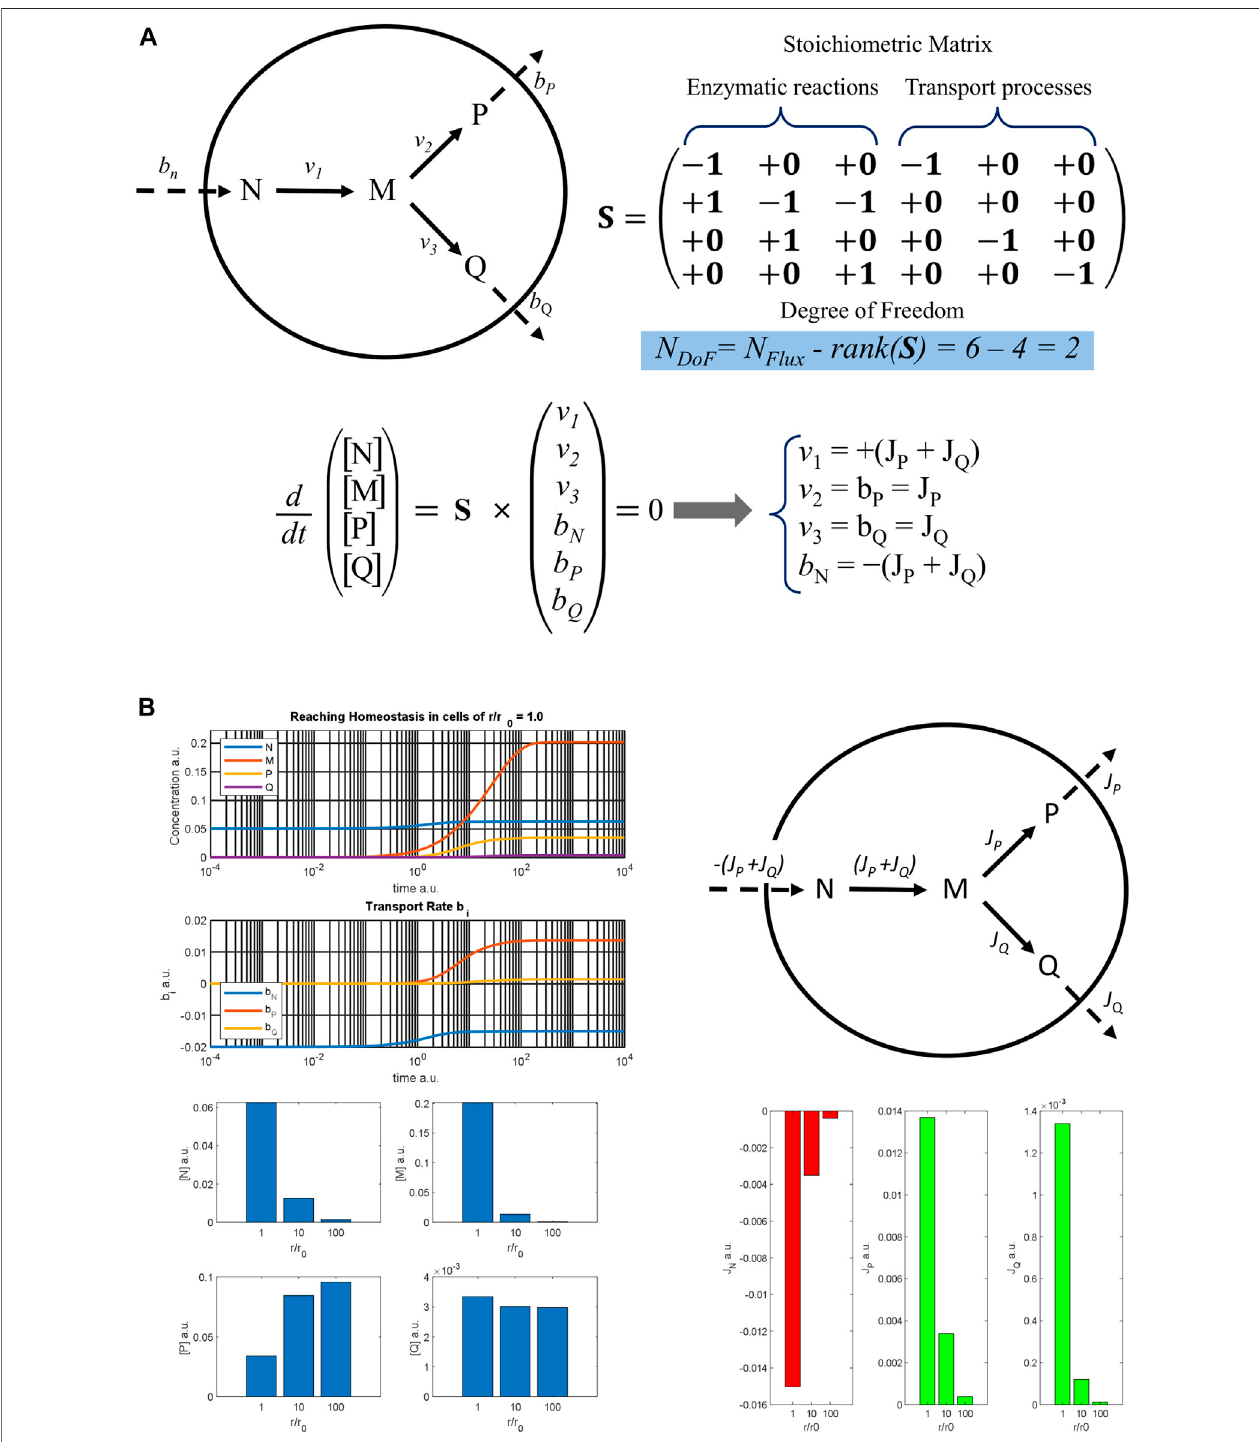
FIGURE 2 | Metabolic model of a three-enzyme pathway (A) A three-enzyme metabolic pathway model is reported with the result of the fl ux balance analysis. The rank of the stoichiometric matrix S is 4, so that the degree of freedom of the algebraic system obtained by applying the stationary condition for homeostasis is 2. Therefore, only two fl uxes, J P and J Q must be determined to know the stationary rates of all the processes at homeostasis. (B) On the top left, the time courses of the metaboliteconcentrationsandoftheratesofthetransportprocessesarereportedagainsttime,showingacellwithanormalradius r 0 asitreacheshomeostasis;on the top right, a metabolic map with the fl ux distribution at homeostasis is sketched; on the bottom left, stationary concentrations of different metabolites are shown, and on the bottom right the values of the fl uxes are reported as diverse histograms for cells with an increasing ratio of r/r 0 .